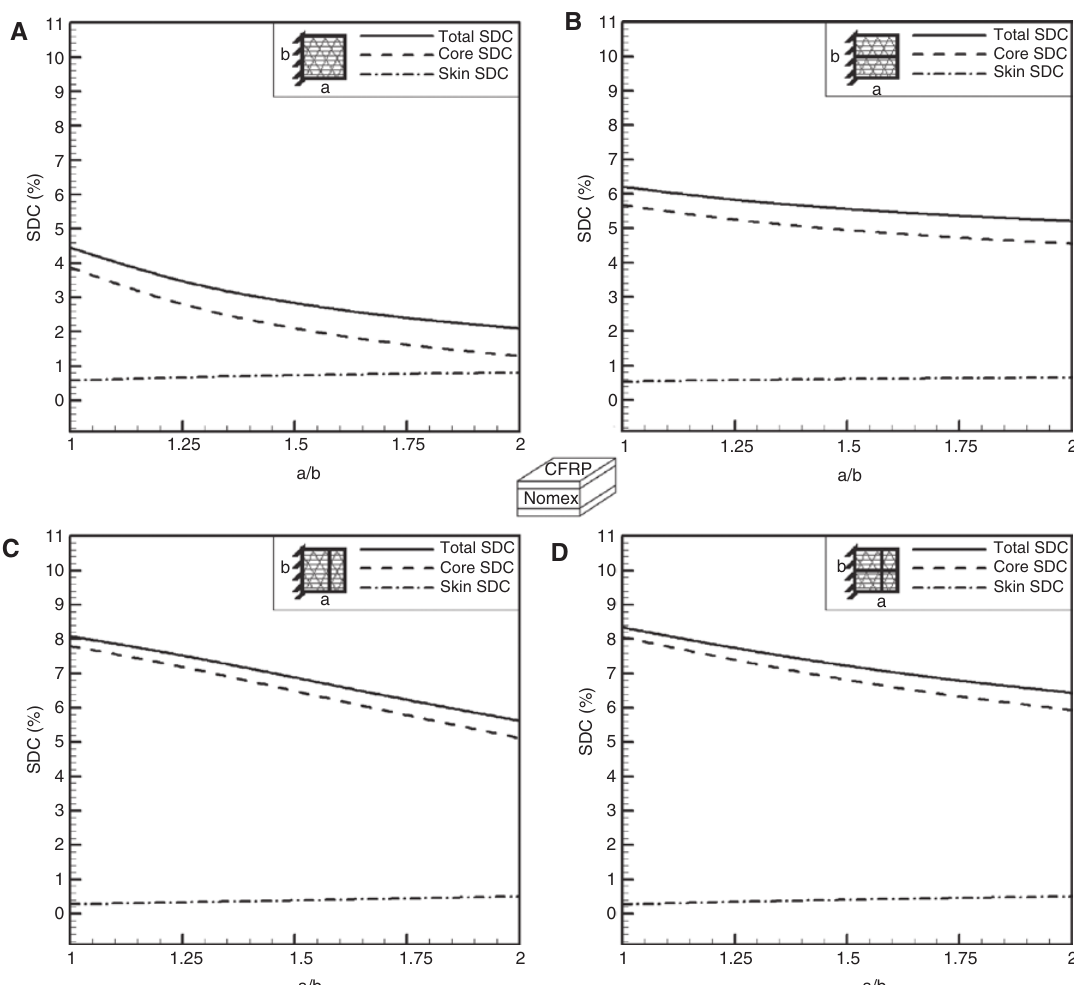
Figure 5: Damping of a cantilevered, [− 60, 0, 60] CFRP/Nomex honeycomb sandwich panel versus aspect ratio, in various modes. (A) First mode, (B) second mode, (C) third mode, (D) fourth